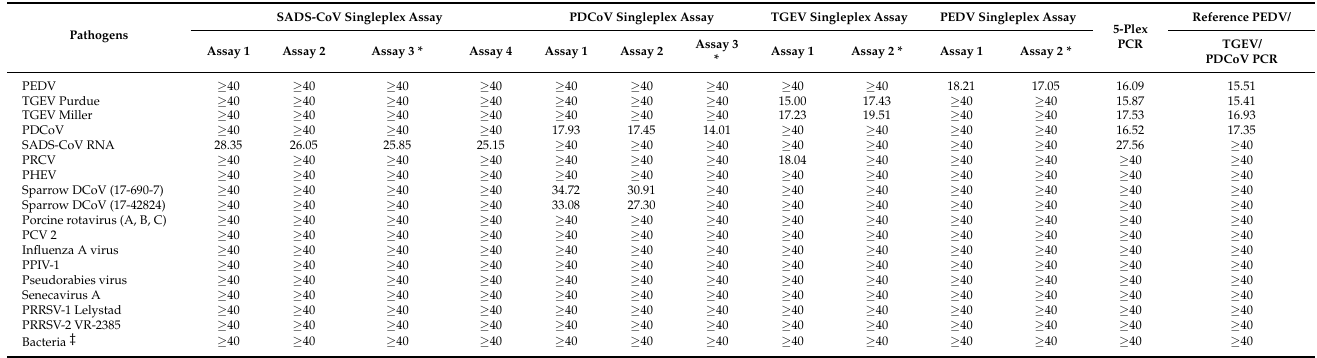
23 swine viral and bacterial pathogens (Table 2), indicating that all four evaluated SADS- CoV singleplex PCR assays had excellent analytical specificity. Table 2. Analytical specificity of various singleplex and multiplex PCRs evaluated in this study.